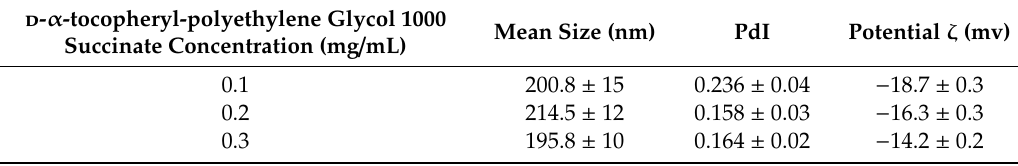
Table 4. Influence of the PEGylant agent concentration on the size and potential ζ of the NLCs. D -α-tocopheryl-polyethylene glycol 1000 succinate concentration (mg/mL)